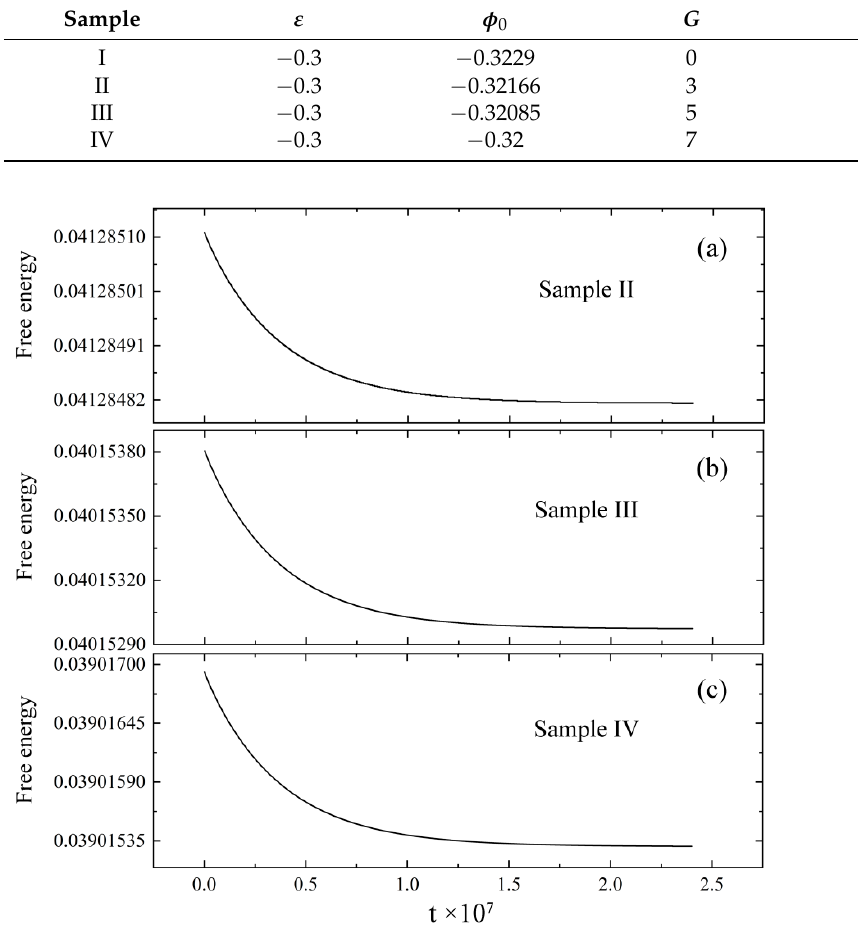
Figure 6. Free energy of sample II–IV versus simulation time during relaxations under a supergravity field with ( a ) G = 3, ( b ) G = 5, and ( c ) G = 7, respectively.